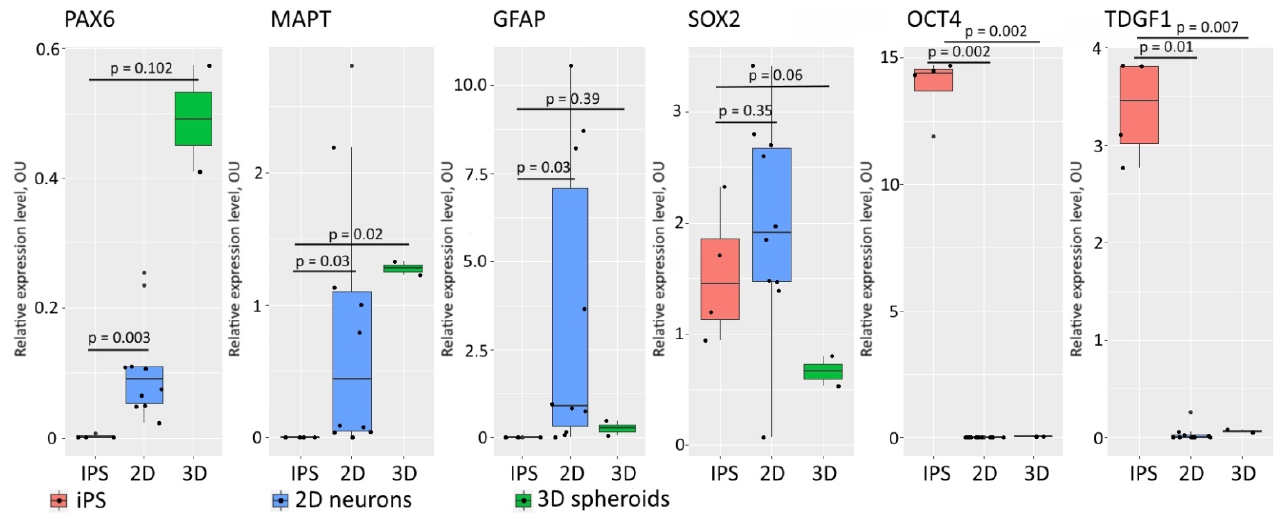
Figure 4. Tracking of changes in expression of pluripotency markers and markers of neural cells during differentiation. Pluripotency markers diminished, while neural markers increased during differentiation. Housekeeping genes REEP5, GAPDH and HMBS were used for normalization of the qRT-PCR data.